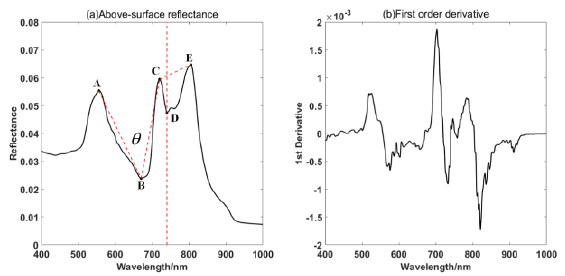
Figure 1. The typical above-surface reflectance of submerged vegetation (a) and the first order derivative spectra (b)